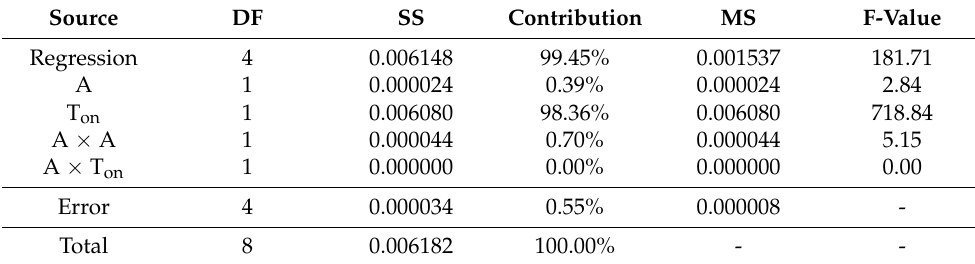
Table 11. Analysis of variance: kerf width—Al6351–5% SiC–10% B 4 C.